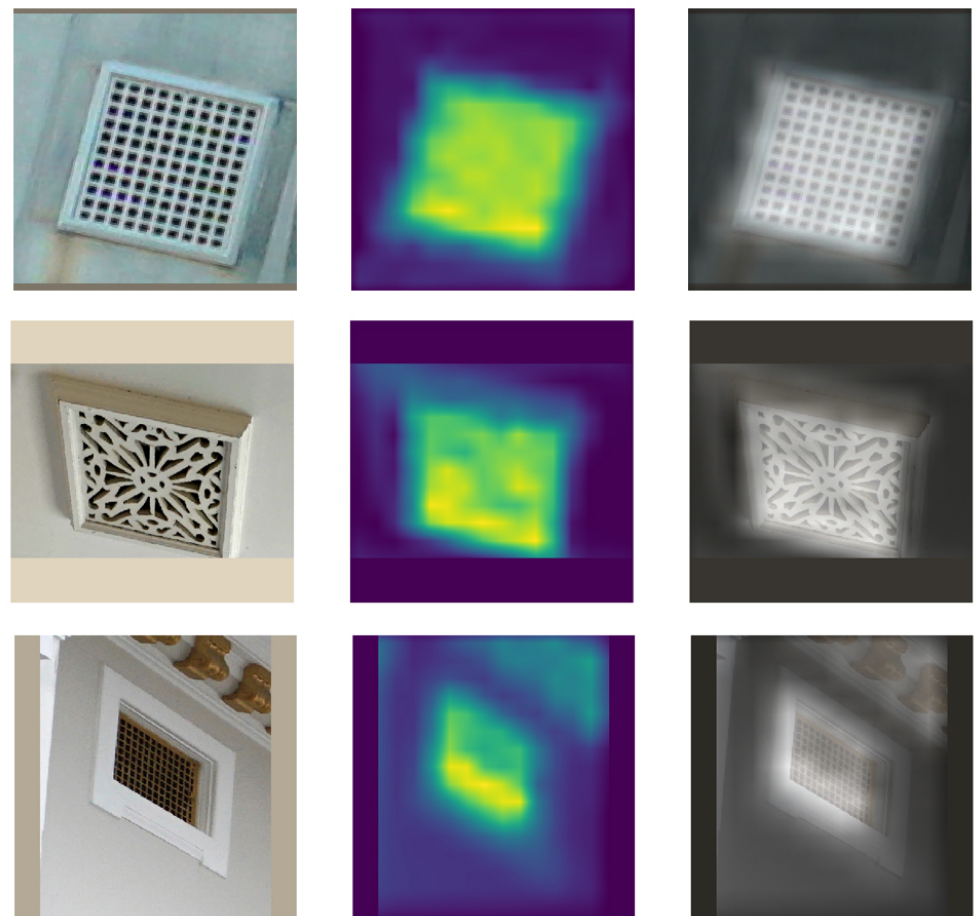
Figure 4. Gradient-weighted Class Activation Maps (Grad-CAM) of ventilation grilles.